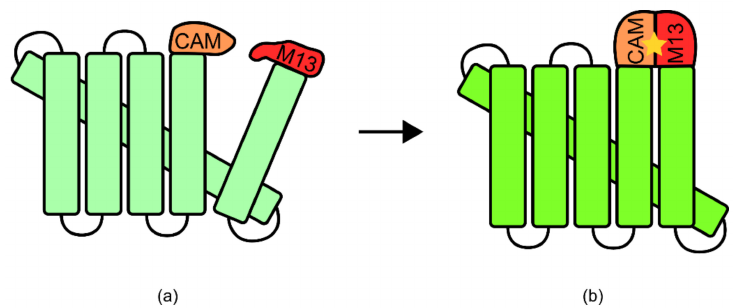
Figure 11. Calcium biosensor. This biosensor is one fusion protein comprised of a cyclically permuted green fluorescent protein (GFP), and calmodulin (CAM), and M13 domains: ( a ) At low calcium concentrations, the CAM and M13 domains do not coordinate efficiently, disrupting the structure of the cyclically permuted GFP. This disruption reduces the fluorescent output of the protein. ( b ) Upon binding of calcium (yellow star), the CAM and M13 domains form a more compact and coordinated configuration, allowing the GFP to return to its natural state, increasing fluorescence. Figure adapted from Nagai, et al. [90].